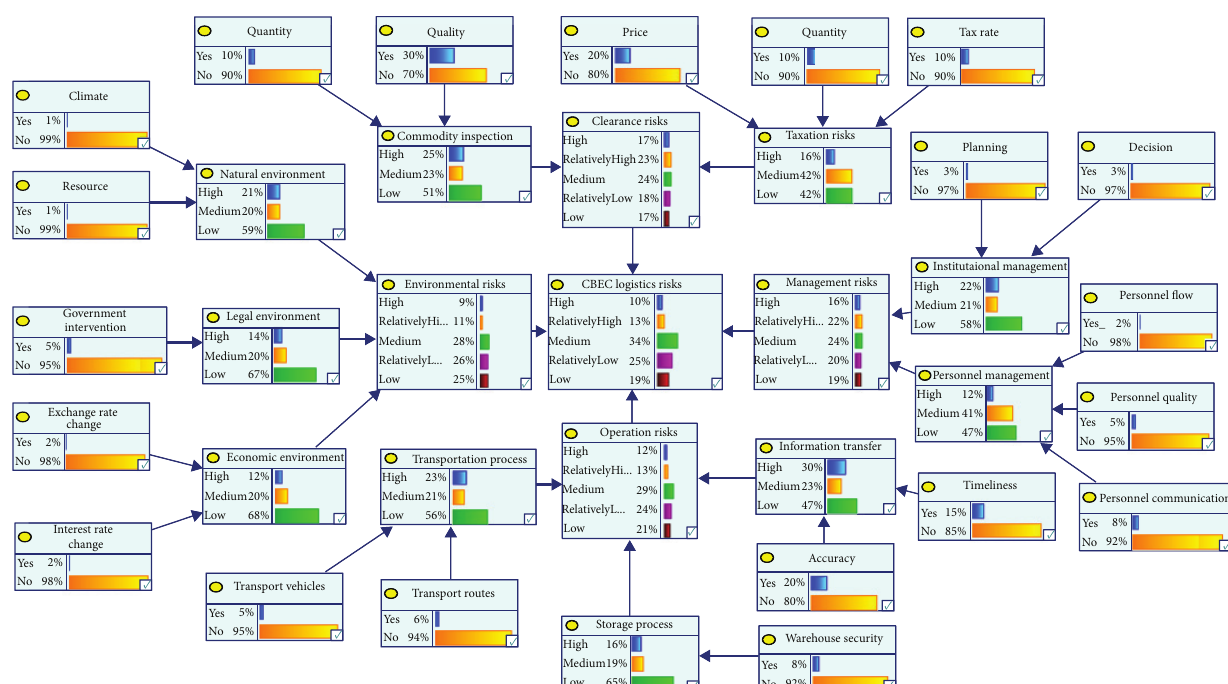
Figure 3: Prior probabilities of our warning mechanism for CBEC logistics risks.